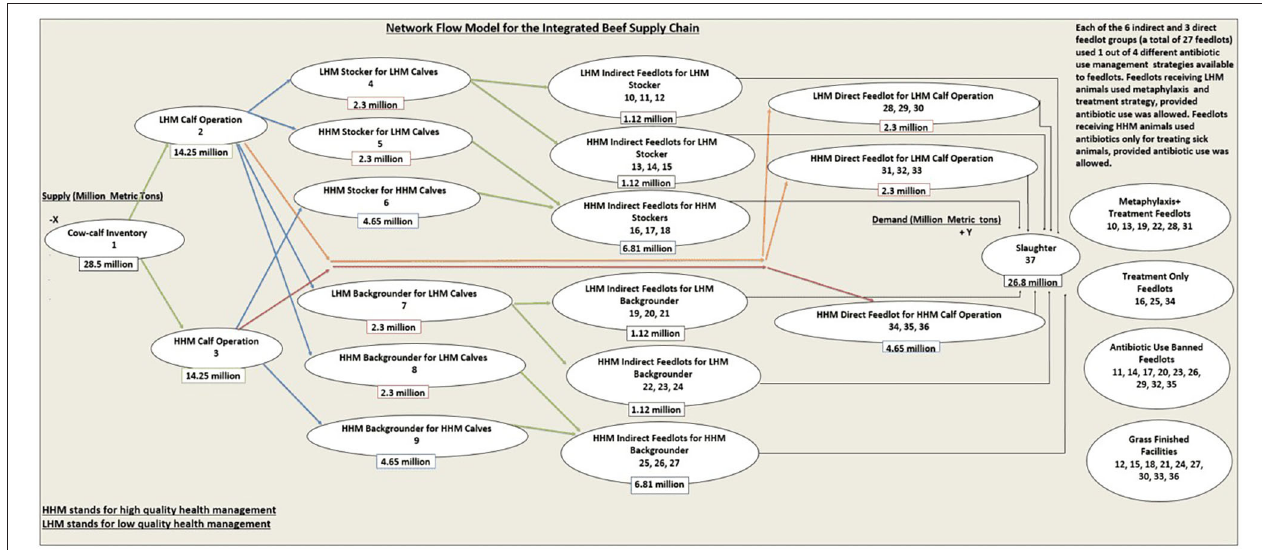
FIGURE 1 | The schematic representation of the conceptual network flow model for the integrated beef supply chain representing the entire United States beef production system.